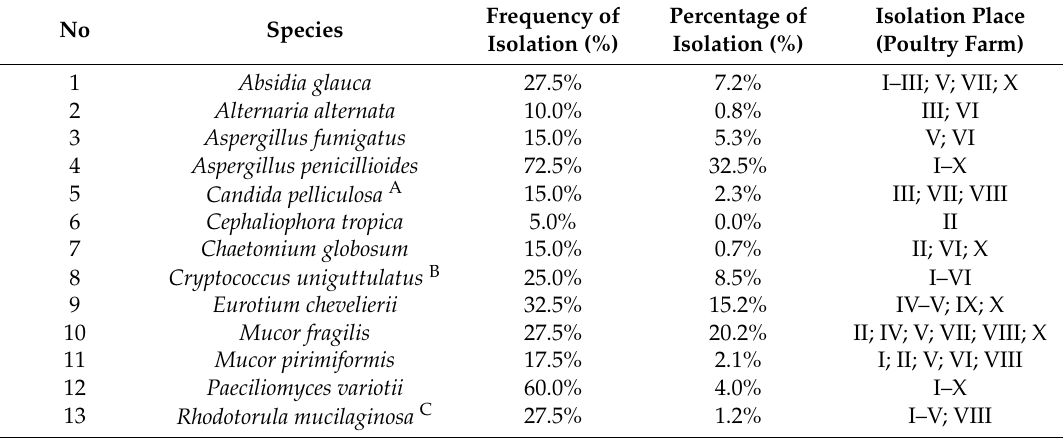
Table 7. Fungal species isolated from settled dust